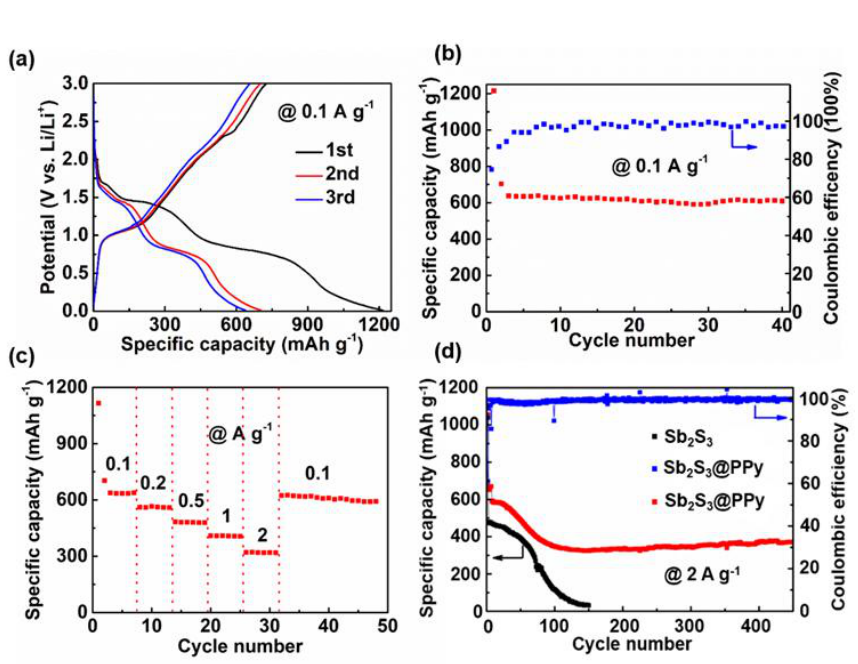
Figure 2. Electrochemical performances of Sb 2 S 3 @PPy or Sb 2 S 3 as an anode in lithium ion batteries (LIBs). ( a ) Galvanostatic charge and discharge curves of Sb 2 S 3 @PPy at 0.1 A g − 1 for the first three cycles. ( b ) Cycling stability and corresponding Coulombic efficiency of Sb 2 S 3 @PPy at 0.1 A g − 1 . ( c ) Rate capability of Sb 2 S 3 @PPy from 0.1 to 2 A g − 1 . ( d ) Cycling stability of Sb 2 S 3 @PPy and Sb 2 S 3 at 2 A g − 1 , and corresponding Coulombic efficiency of Sb 2 S 3 @PPy at 2 A g − 1 .